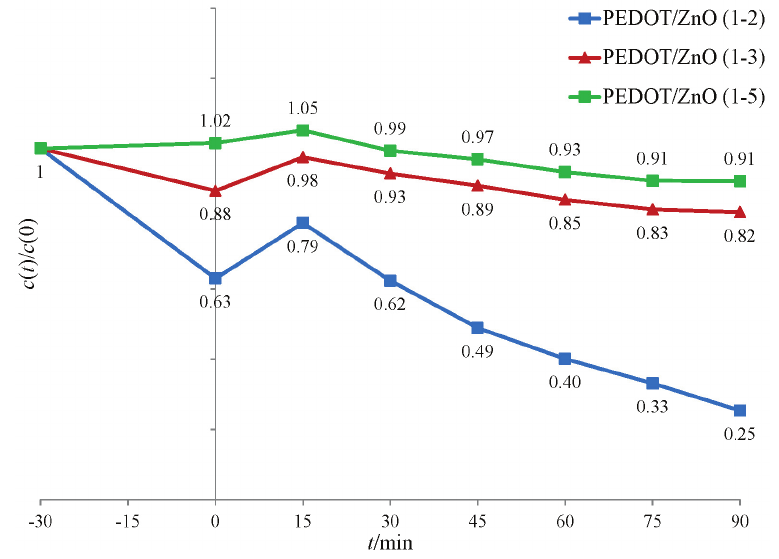
Fig. 9 – Rate of discoloration of RR45 dyes during photocatalysis under UV-A irradiation by using synthesized PEDOT/ZnO nanocomposite photocat-